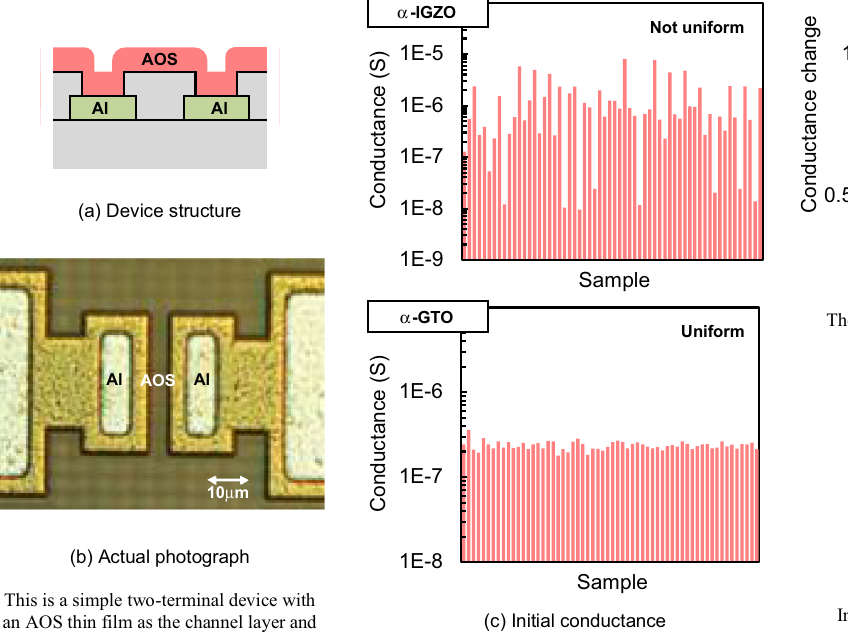
Figure 2. Synapse device made of the AOS thin film.